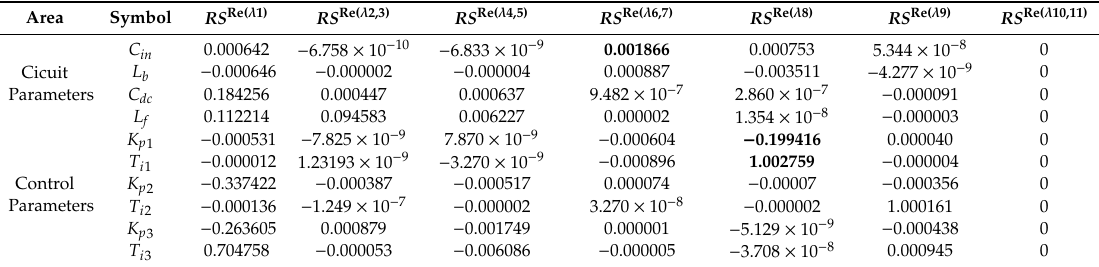
Table 6. Relative eigenvalue sensitivity of di ff erent parameters in CS 1